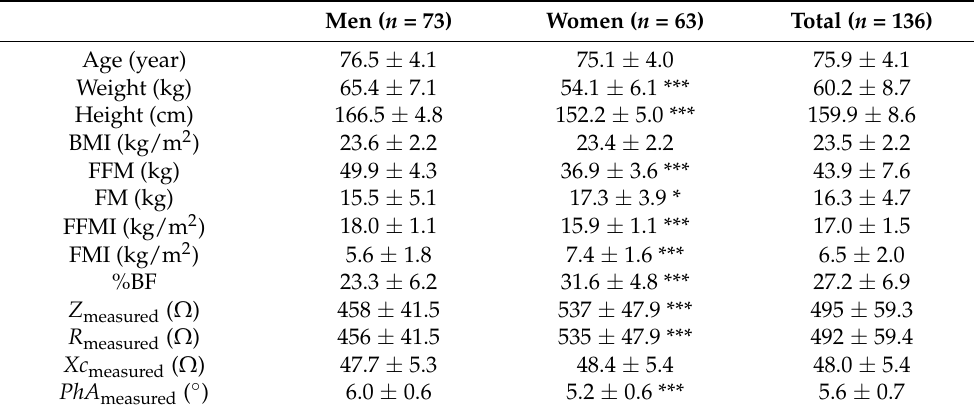
Table 1. General characteristics of elderly participants.